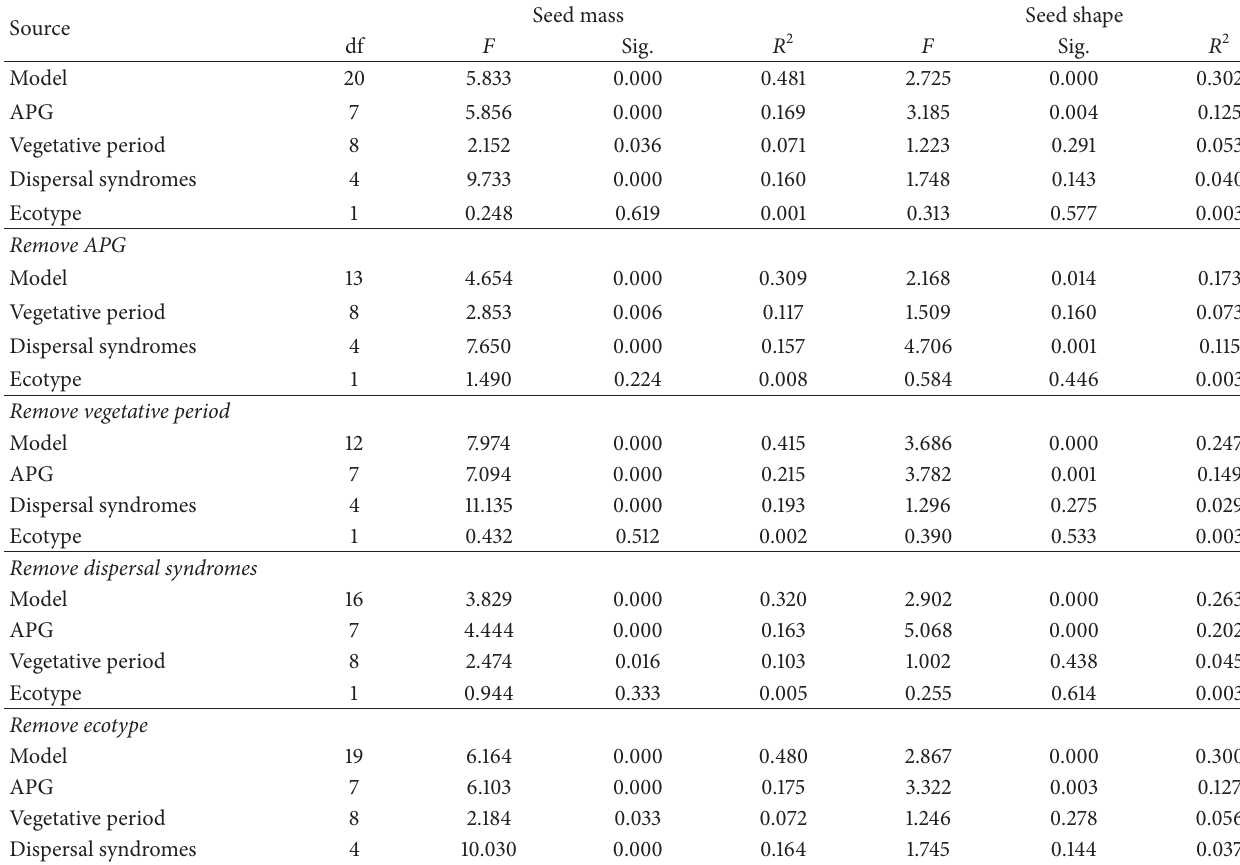
Table 2: Multiway tests of between-subjects